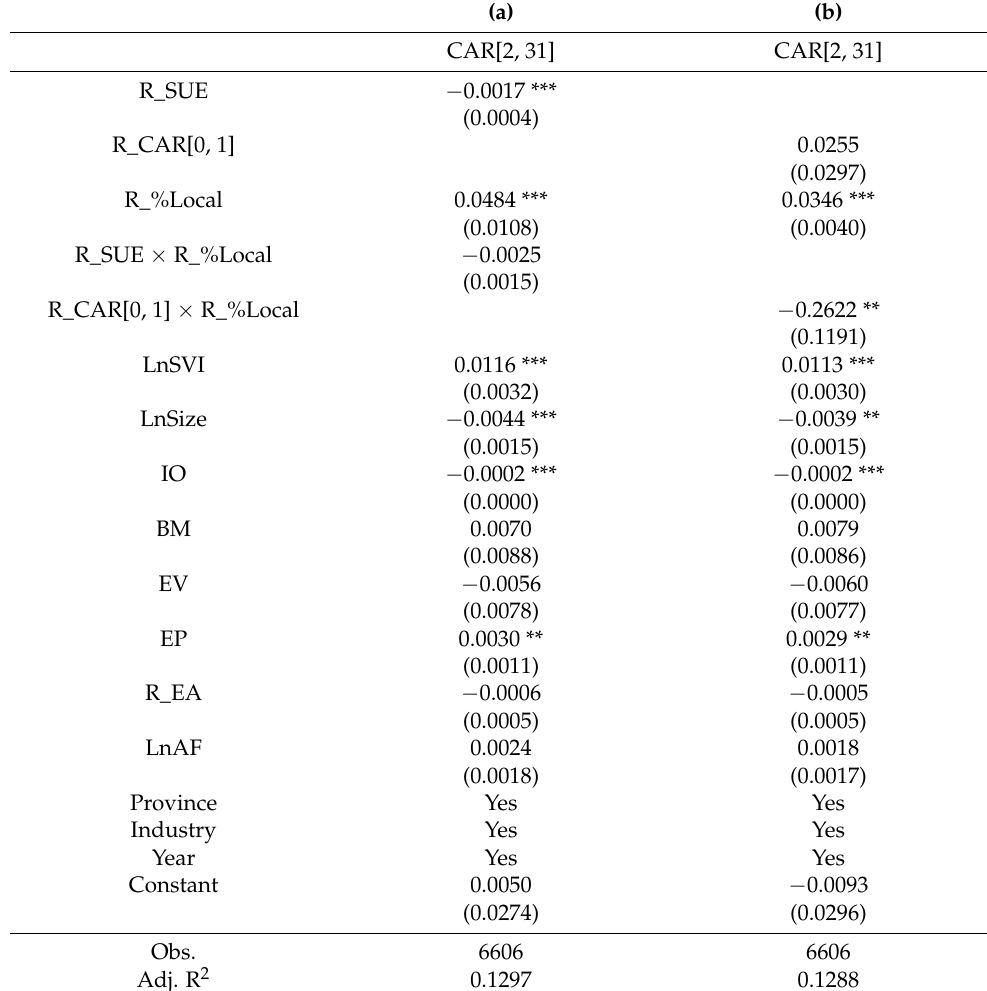
Table 7. Local Attention and Post-Earnings